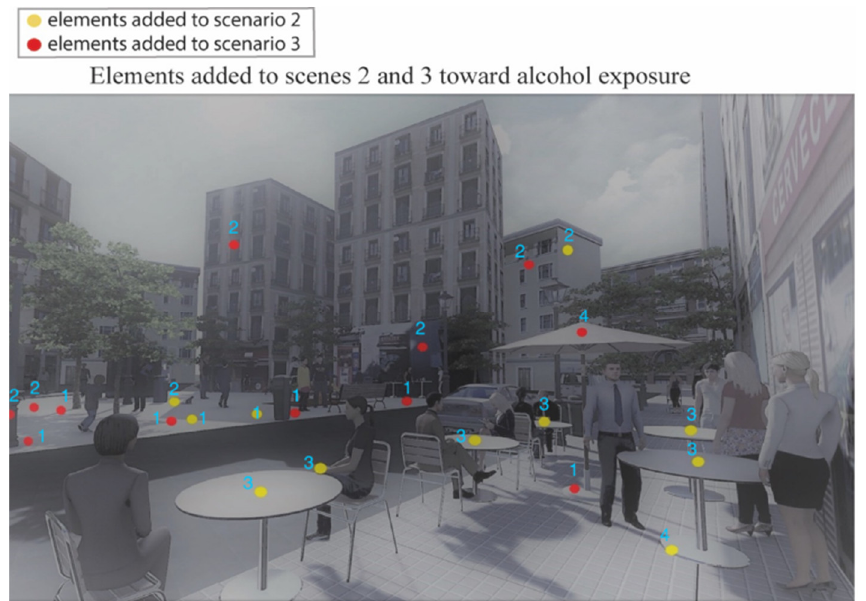
Figure 4. Points where we added alcohol elements (yellow points: medium-exposure scenario; red points: high-exposure scenario). Alcohol elements included: (1) litter related with alcohol; (2) displays with alcohol promotion; (3) alcoholic beverages (or people consuming alcohol); and (4) alcohol promotion associated to alcohol outlets.